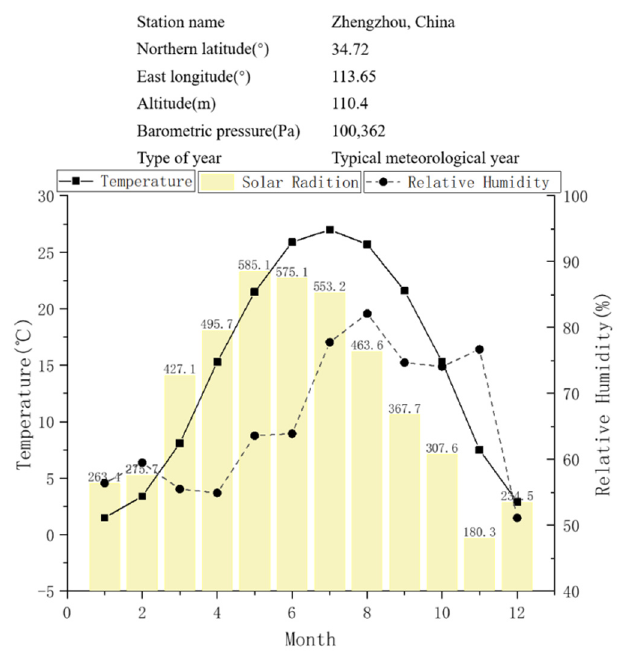
Figure 1. Meteorological data of Zhengzhou, China.